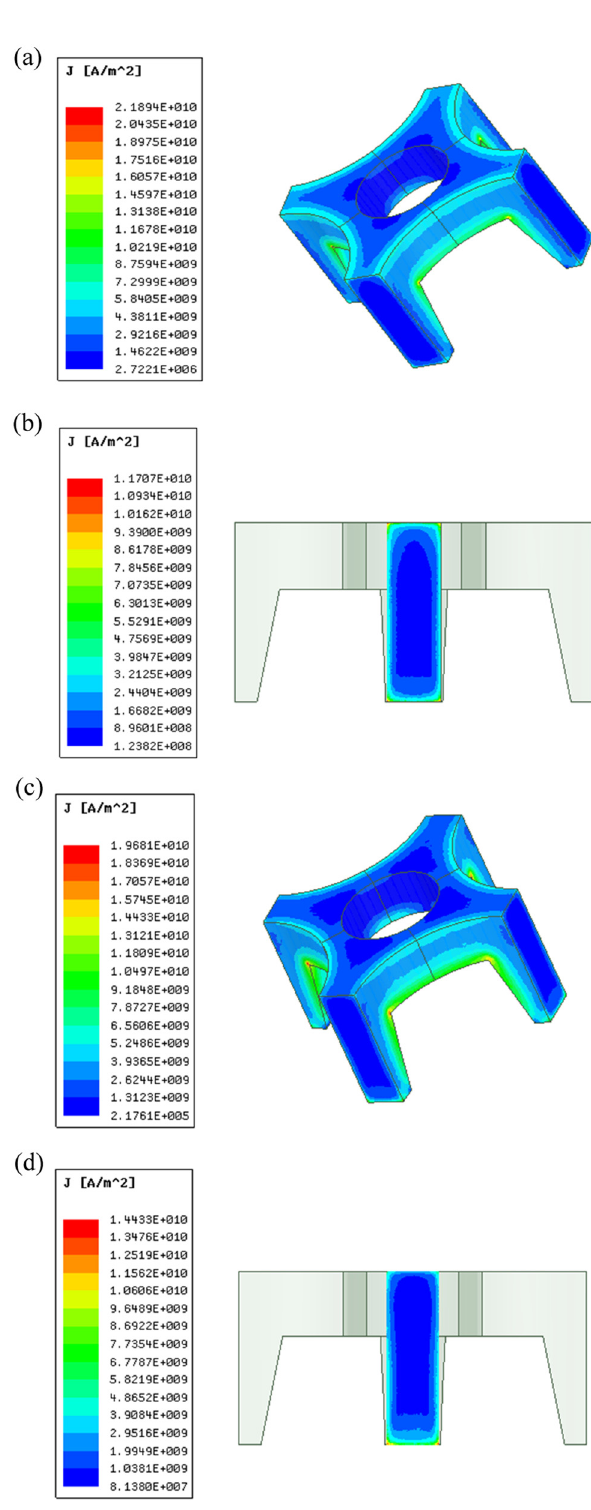
Figure 7: Current distribution in the armature. ( a ) Current density of CFREL, ( b ) current in contact surface of CFREL, ( c ) current density of ECFREL, and ( d ) current in contact surface of ECFREL.